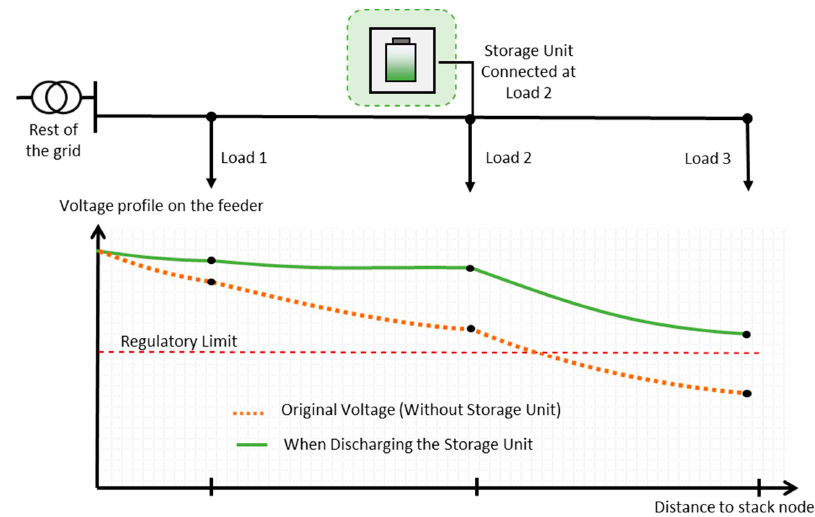
Figure 4. Illustration of voltage support on a fictive feeder.